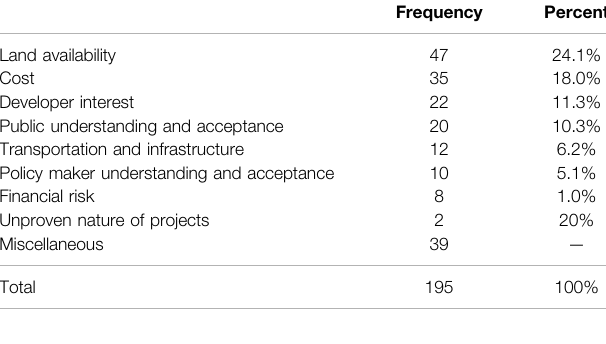
TABLE3| Challengesencountered described as “ other ” (LevineandInam, 2004).